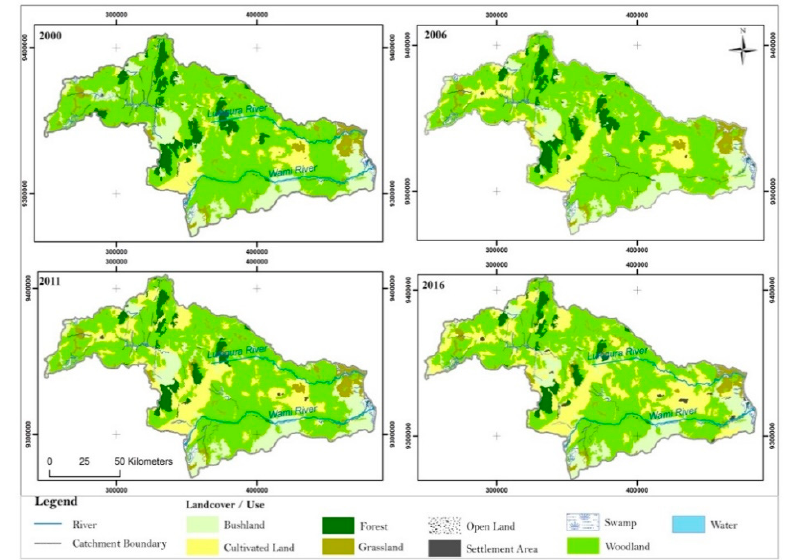
Figure 5. LULC maps for 2000, 2006, 2011, and 2016 at Wami Sub-catchment (downstream).